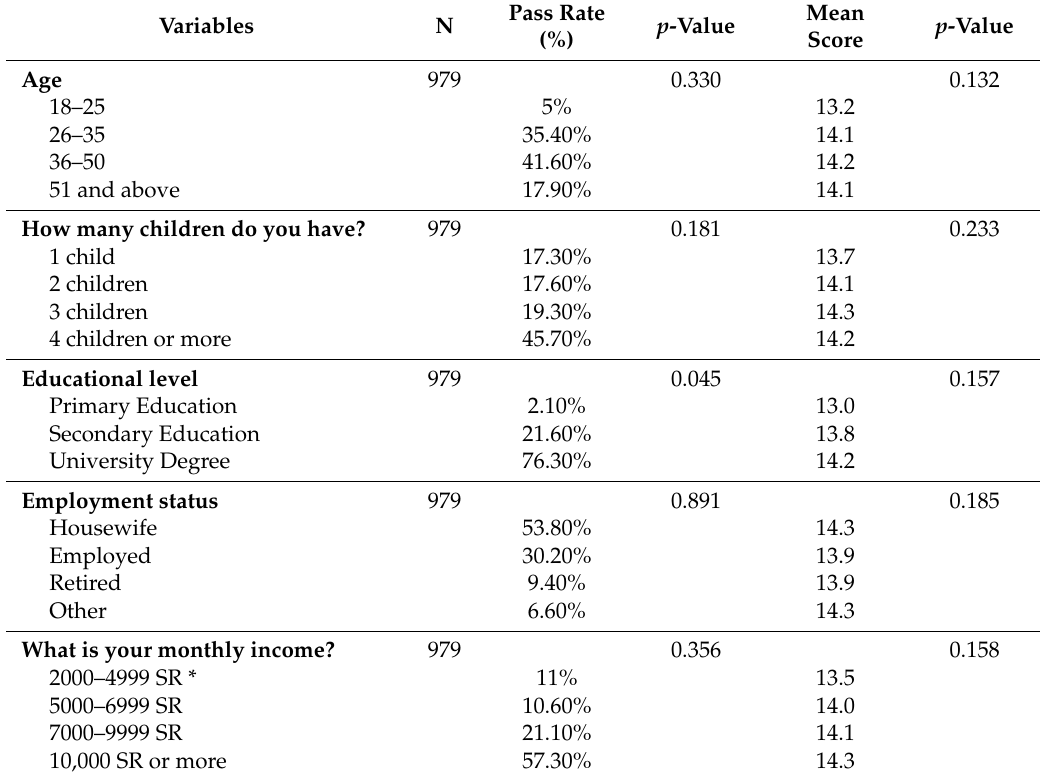
Table 7. The relationship between the demographic characteristics of participants and their food safety knowledge and